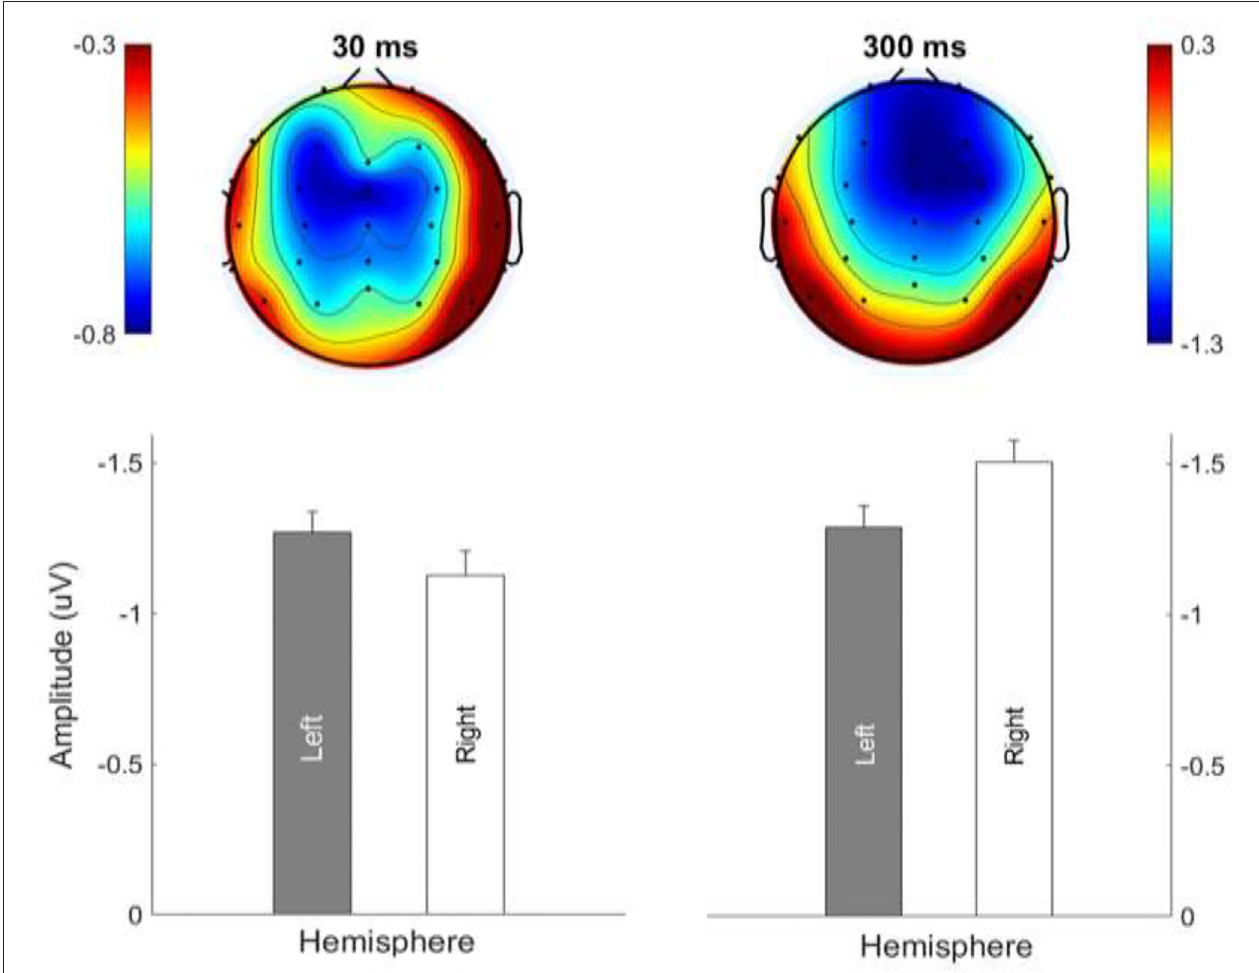
FIGURE 9 | Hemispheric lateralization of MMN topography for frequency sweeps at local (30ms; left panels) and global (300ms; right panels) timescales. Color bar is scaled to the MMN mean amplitude in each topography. Negativity is indicated by blue and positivity by red